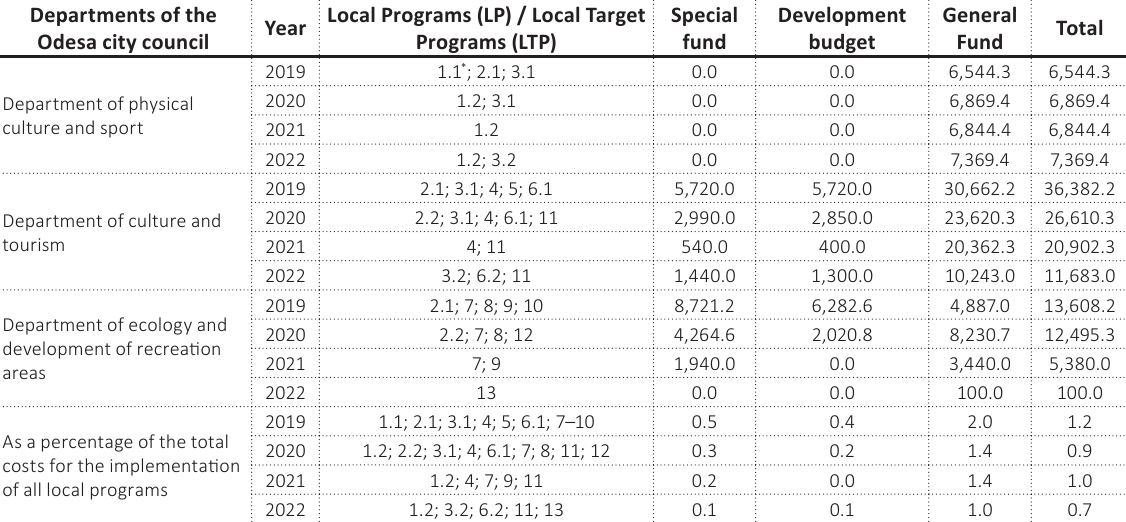
Table 1. Expenditures on recreational and tourist-relevant programs in the structure of distribution of budget expenditures of the city of Odesa for the implementation of all local programs, thousand UAH, during